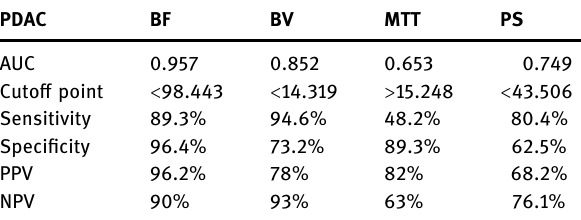
Table 3: Analysis of sensitivity, speci fi city, PPV and NPV, and ROC for averaged BF, BV, MTT, and PS for the presence of